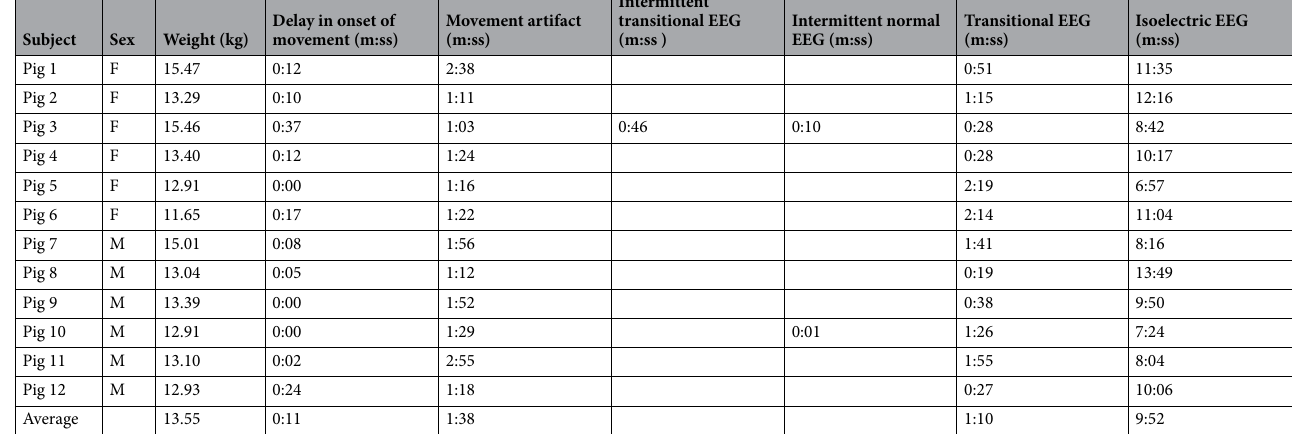
Table 1. Objective data from each animal including sex, weight, and time in each EEG phase with averages in the bottom